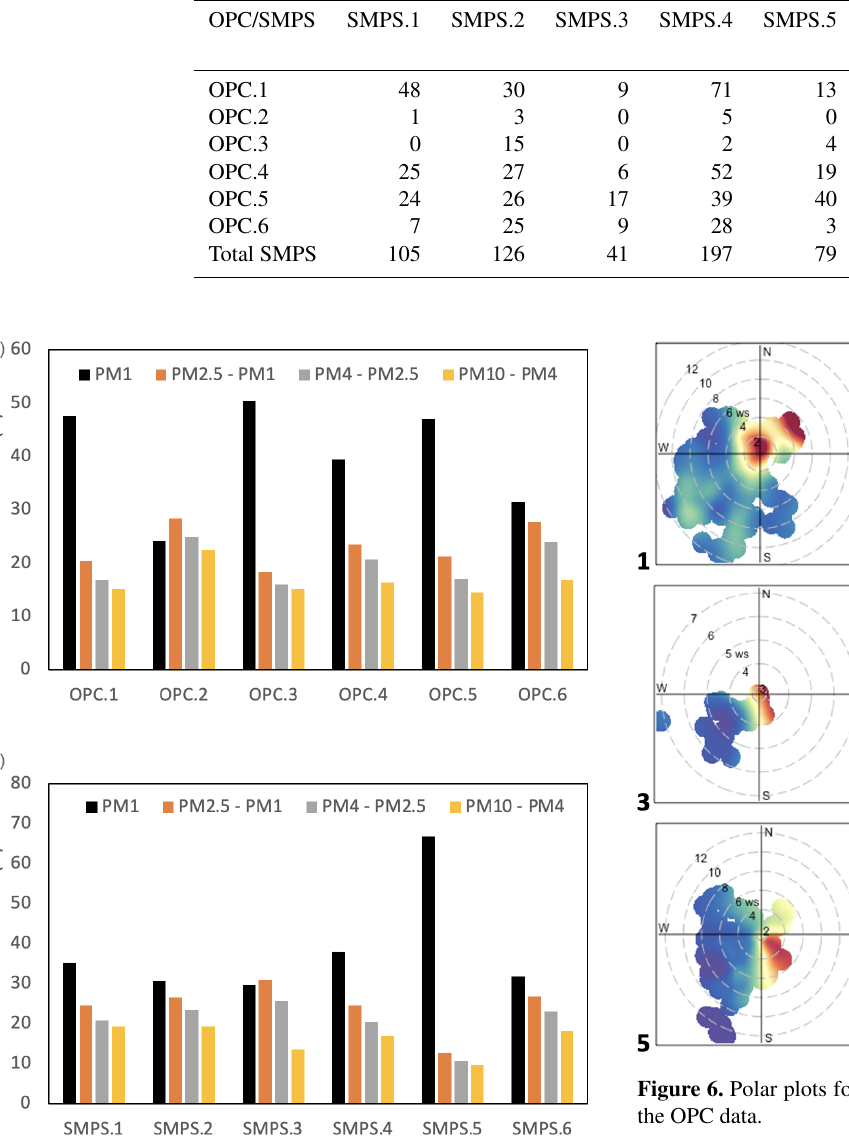
Table 3. Simultaneous occurrences of the clusters formed by both the OPC and SMPS.